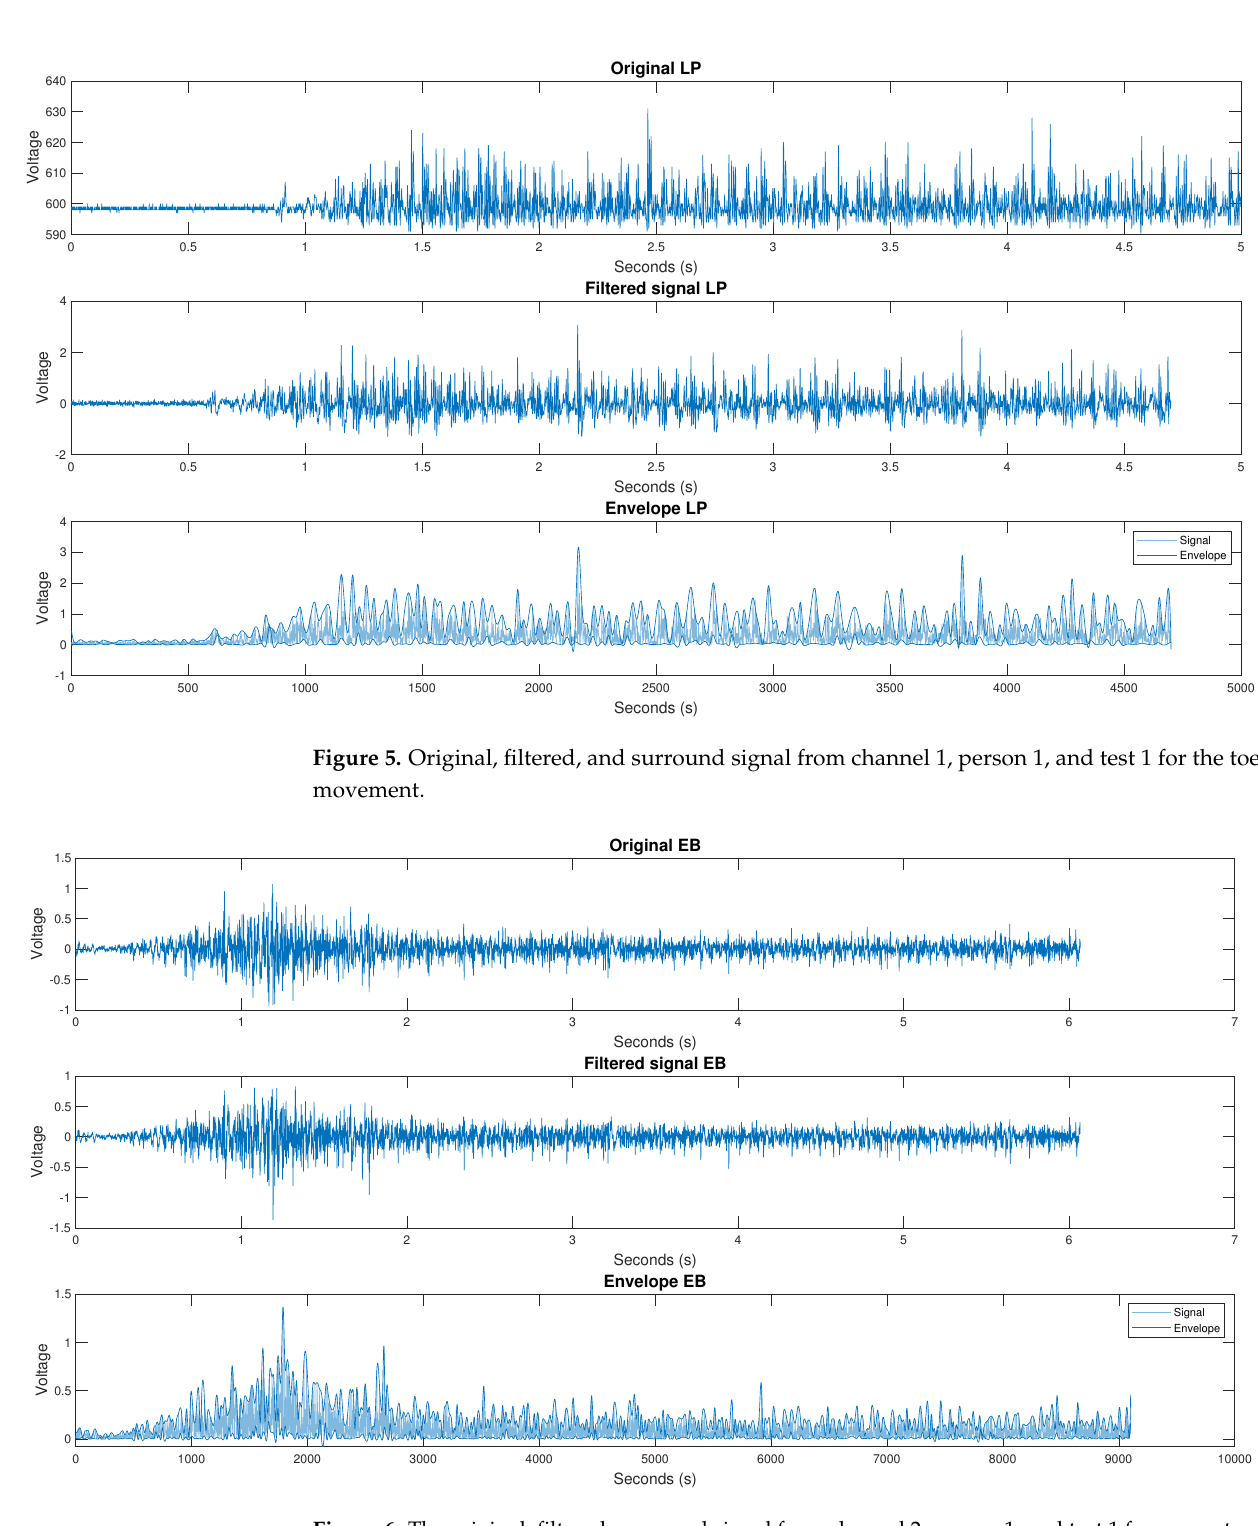
Figure 6. The original, filtered, surround signal from channel 2, person 1, and test 1 for arm extension